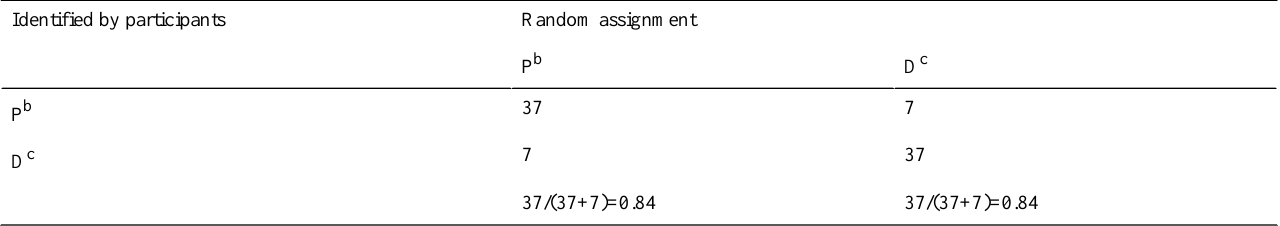
Table 3. Contingency table of assigned and identified conversational agent interaction styles a .